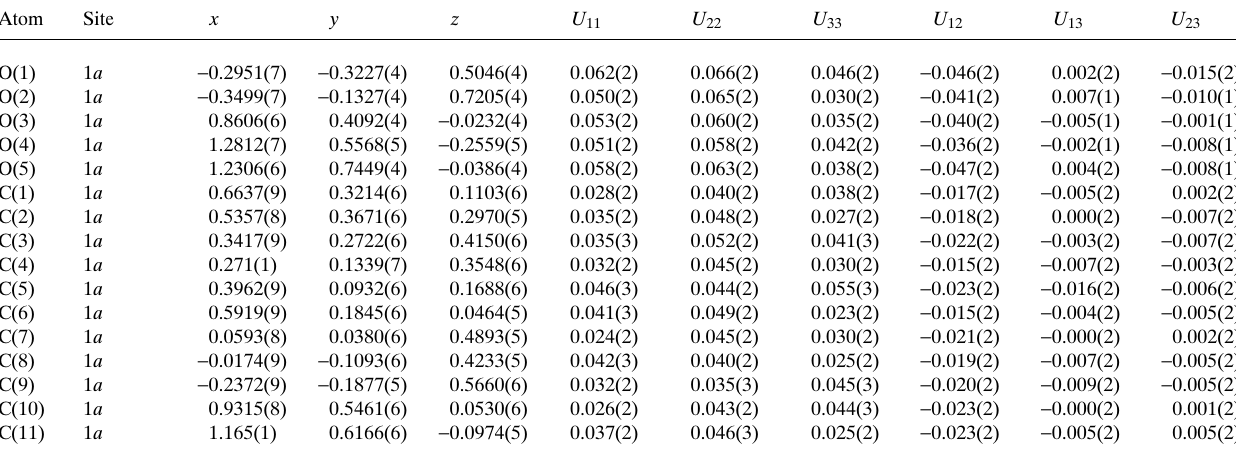
Table 3. Atomic coordinates and displacement parameters (in Å 2 ) .